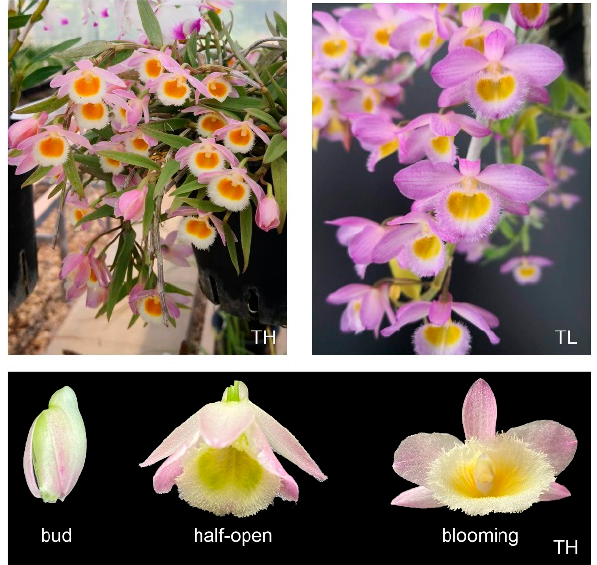
Figure 1. D. loddigesii . TH, high-scented variety; TL, light-scented variety; the bottom image shows the three flowering periods of TH.